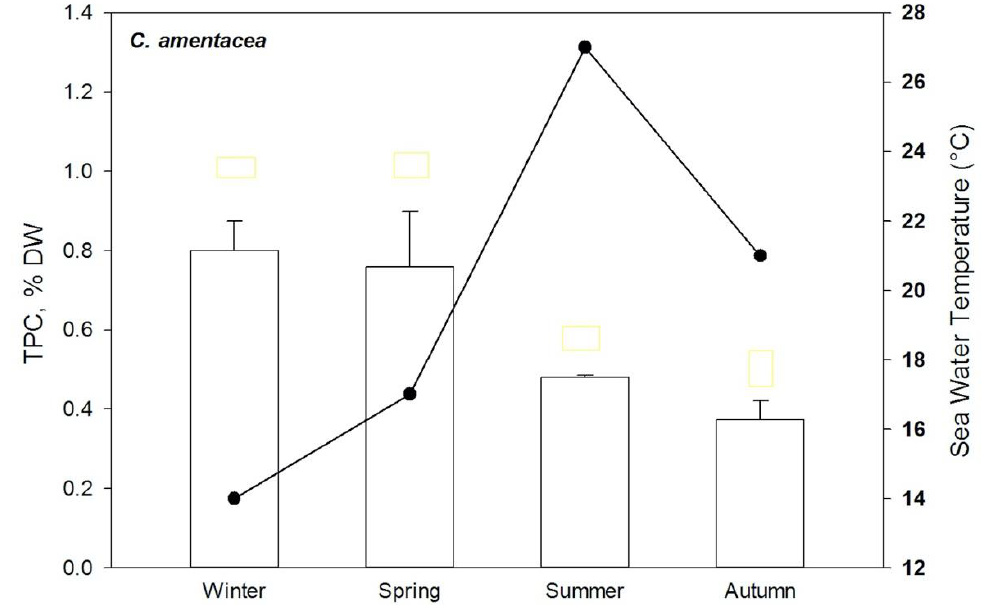
Figure 4. Carpodesmia amentacea : seasonal variations of the TPC and sea water temperature. Bars represent mean ± standard deviation ( n = 5) (from [81]).